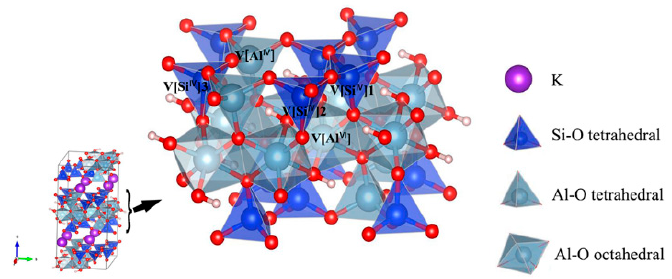
Figure 5. The substituted location in muscovite. Table 2. The cell parameters and substitution energies of five configurations.